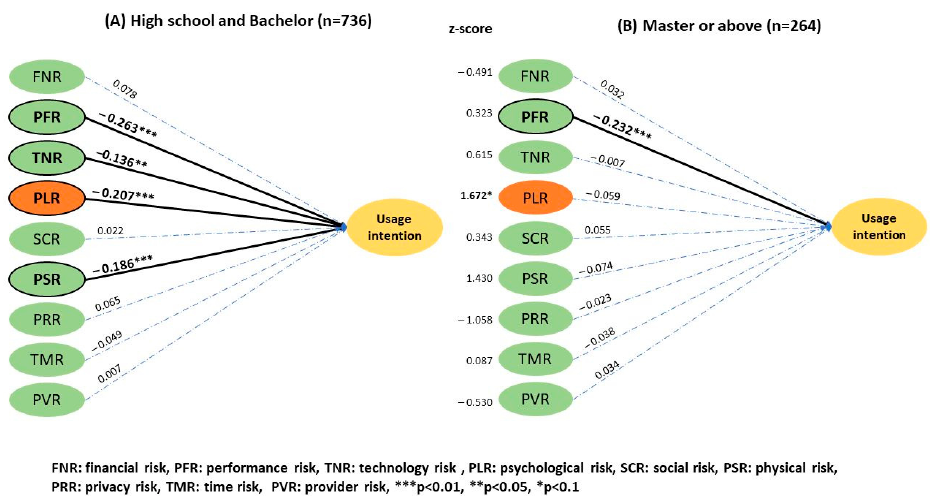
Figure 6. Results of the two-group structural model of educational status.